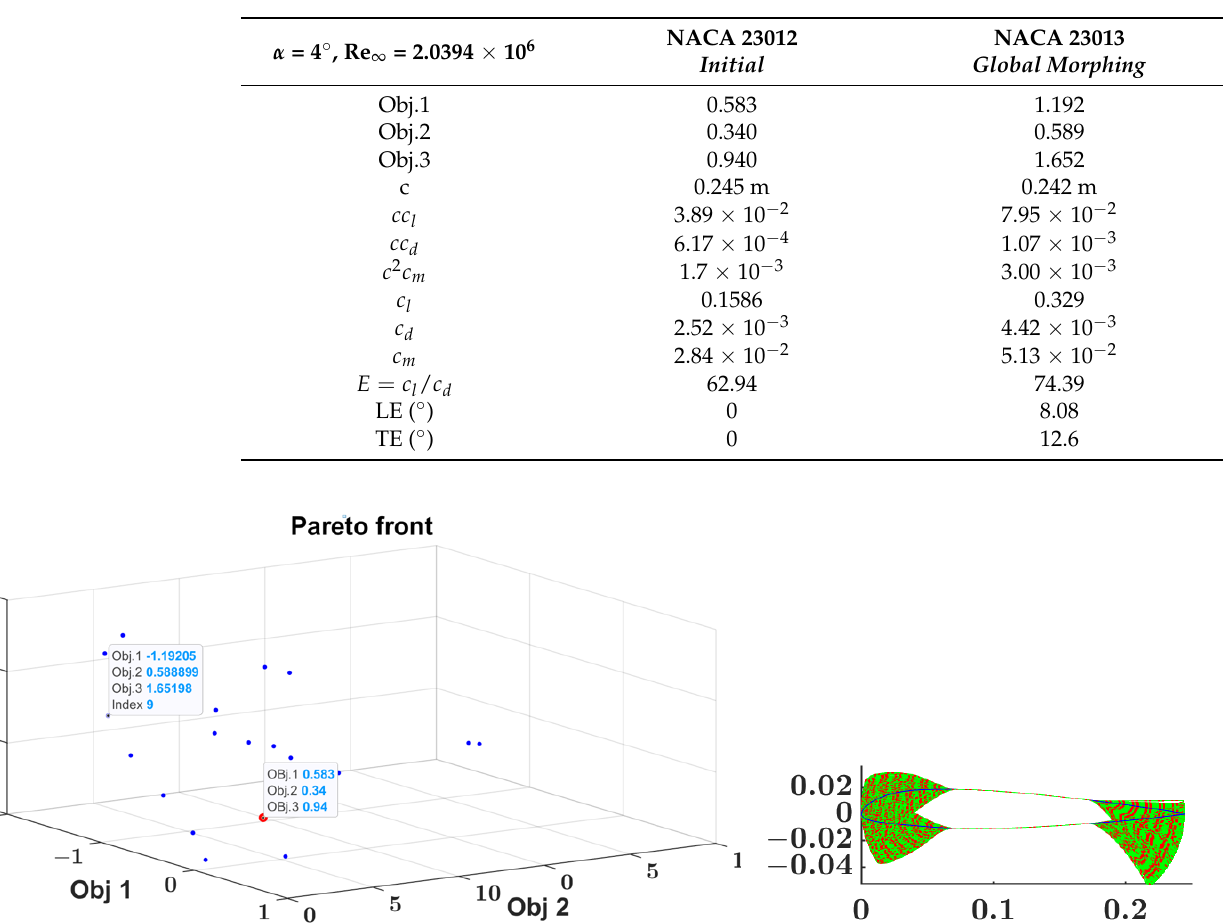
Table 16. Initial and “ global ” morphed NCA 23012.